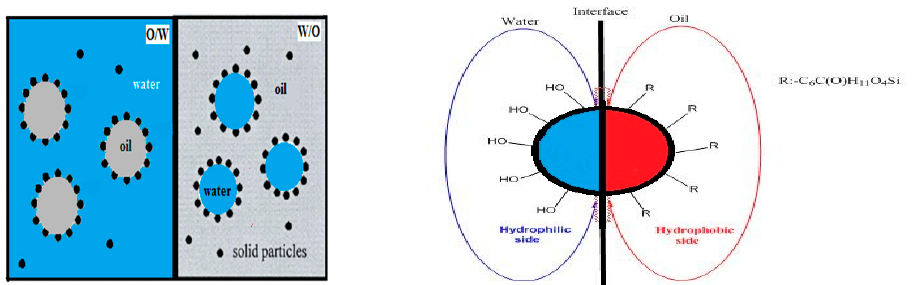
Figure 3. Schematic diagram of the Pickering emulsification stabilization mechanism of homogeneous Janus nanoparticles and asymmetric amphiphilic Janus